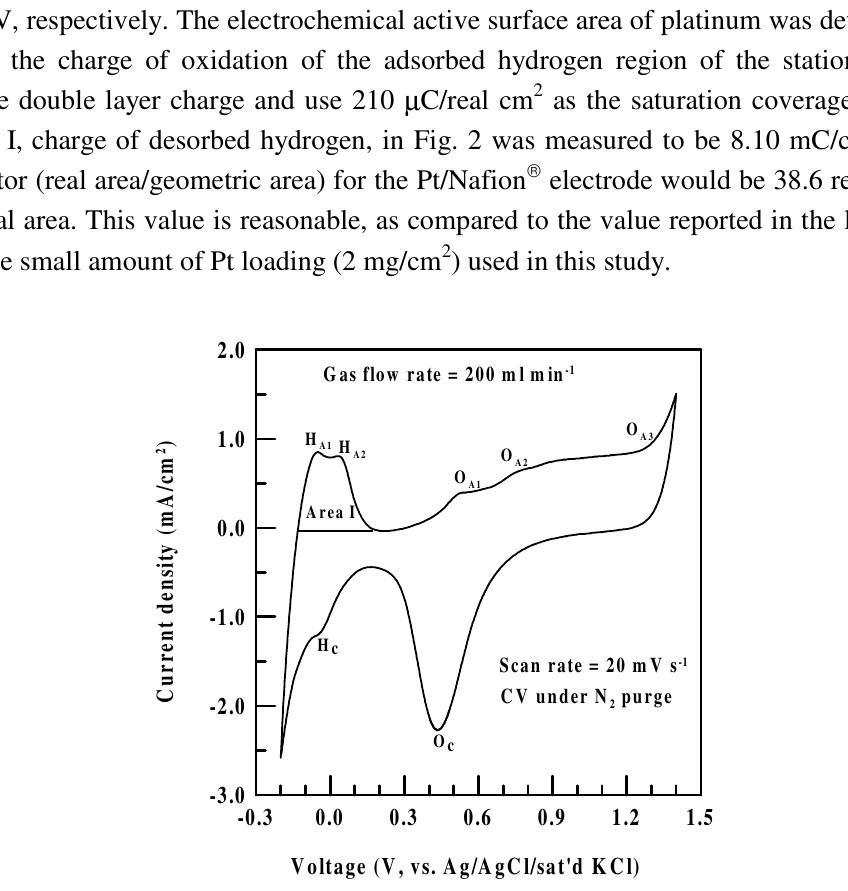
at 20 mV/sec. Solution phase: 0.5 M H 2